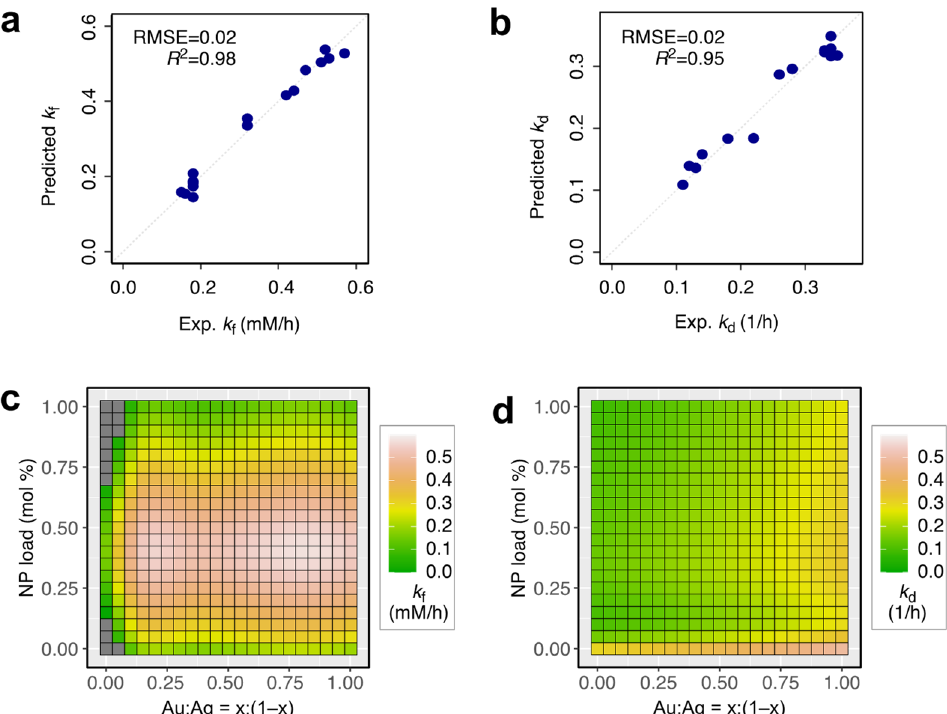
Figure 2. Pair-wise comparison of the accuracy between the experimental observation of H 2 O 2 ( a ) production rate k f and ( b ) decomposition rate k d as function of the Au x Ag (1– x ) co-catalyst nanoparticle composition and nanoparticle loading (mol %) within TiO 2 . Heatmap of predicted reaction rate by GAM for ( c ) k f and ( d ) k d